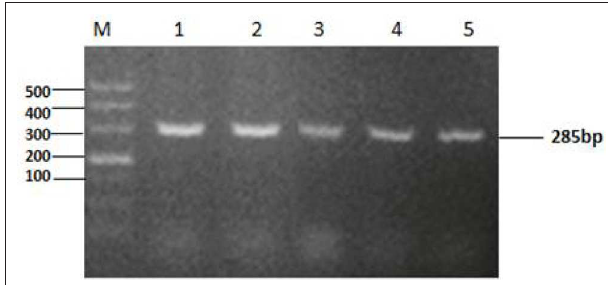
FIGURE 1 | Cloning of tyeA gene. M: DL2000 marker. Lane 1-5:The 285bp fragment was amplified from genomic DNA of the wild-type strain HY9901 using primer pairs of tyeAP1-for/tyeAP1-rev (Lane 1, 2, 3, 4, 5:Tm = 56 ◦ C, 57 ◦ C, 58 ◦ C, 59 ◦ C, 60 ◦ C).